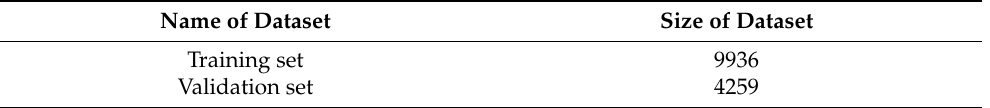
Table 2. The details of the two datasets.